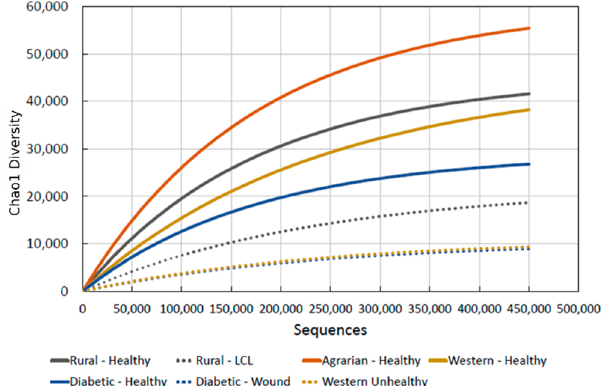
Figure 8. Graph showing the combined benchmarks taken from our previous work [34]. This graph formed the basis for the skin health measuring mechanism, with benchmark values of diversity for a range of different states of health on the skin. For an explanation of each please see our previous work.